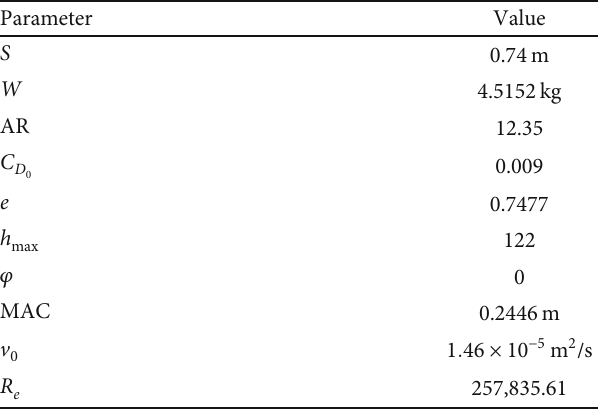
Table 2: Conceptual design data.